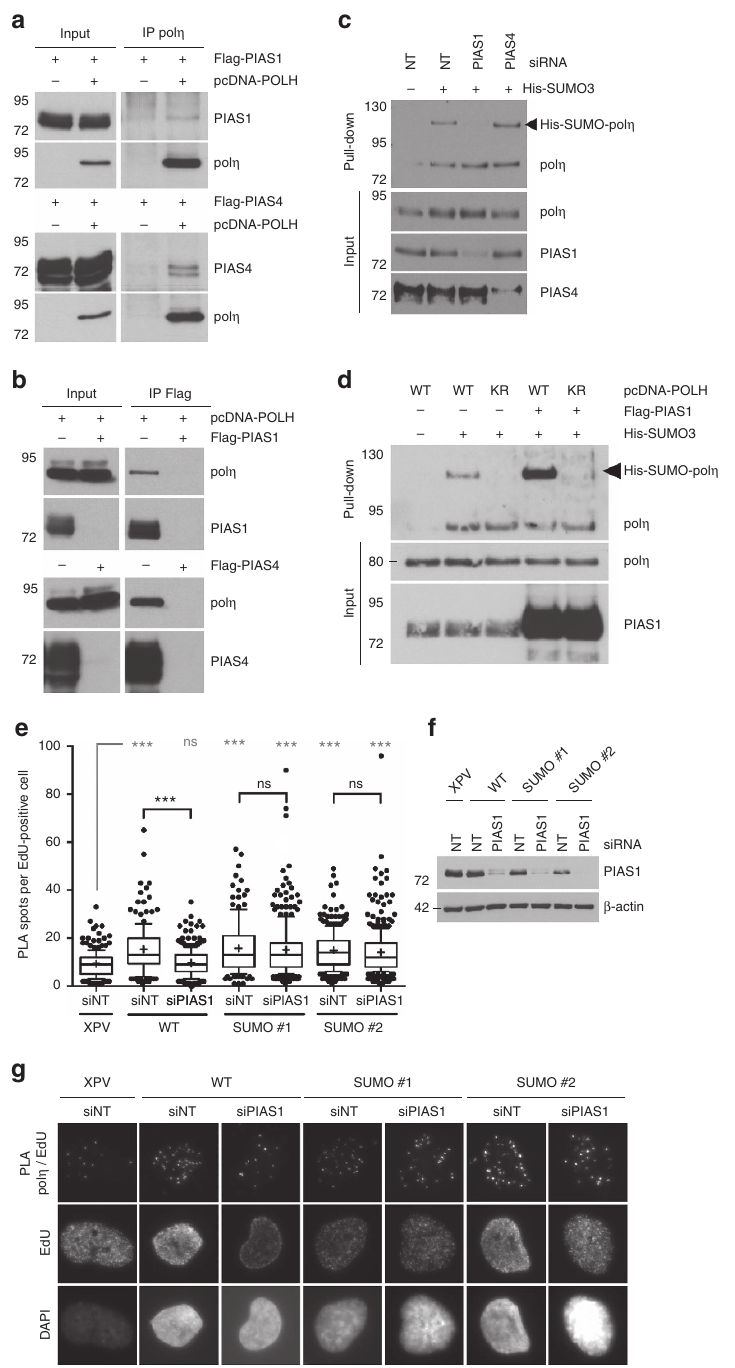
Figure 7 | Pol g is SUMOylated in a PIAS1-dependent manner. ( a ) 293FT cells were transfected with pcDNA-POLH and Flag-PIAS1 or Flag-PIAS4 and co-immunoprecipitations were performed using an anti-pol Z antibody. ( b ) Reversed immunoprecipitations were performed with an anti-Flag antibody. ( c ) 293FT cells were transfected with the indicated siRNAs 24h before co-transfection of plasmids expressing pol Z and His-SUMO3. Denaturing Ni pull-down was carried out as described in Fig. 2. ( d ) WTor K163R (KR) pol Z was co-expressed in 293FTcells with His-SUMO3 and Flag or Flag-PIAS1 and cells were processed as in c . ( e ) XPV, pol Z WT and pol Z SUMO cells were transfected with non-targeting or PIAS1 siRNAs. Nascent DNA was pulse-labelled with EdU for 5min and cells were pre-extracted and fixed. Biotin was conjugated to EdU by click chemistry in order to perform an in situ PLA between pol Z and EdU-biotin. EdU-biotin was then counterstained using a fluorescent secondary antibody. The distribution of the number of PLA spots per EdU-positive cells was assessed in two independent experiments. One representative experiment is shown in box-plot with 10–90 percentile whiskers ( n 4 150, ns: not significant, *** P o 0.001, Mann–Whitney test). ( f ) Western blot showing the efficiency of PIAS1 depletion. ( g ) Representative images of the PLA experiment quantified in ( e ) (magnification (cid:2)